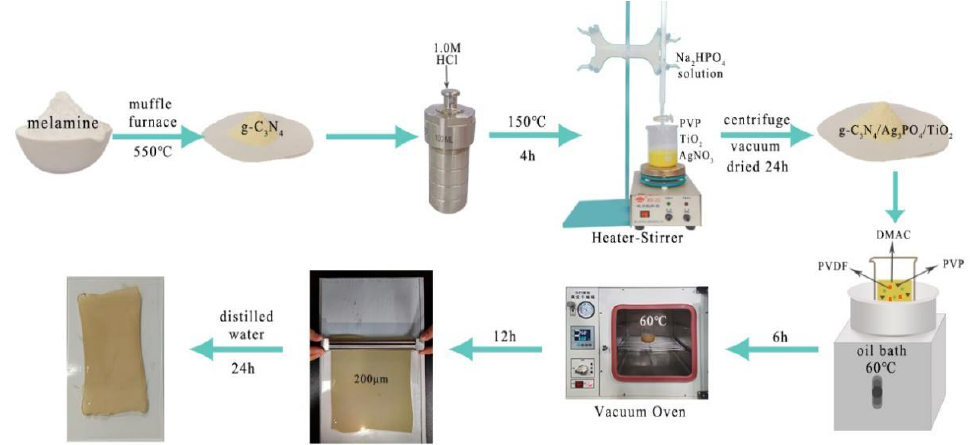
Figure 1. Schematics of nanocomposite synthesis and membrane preparation.